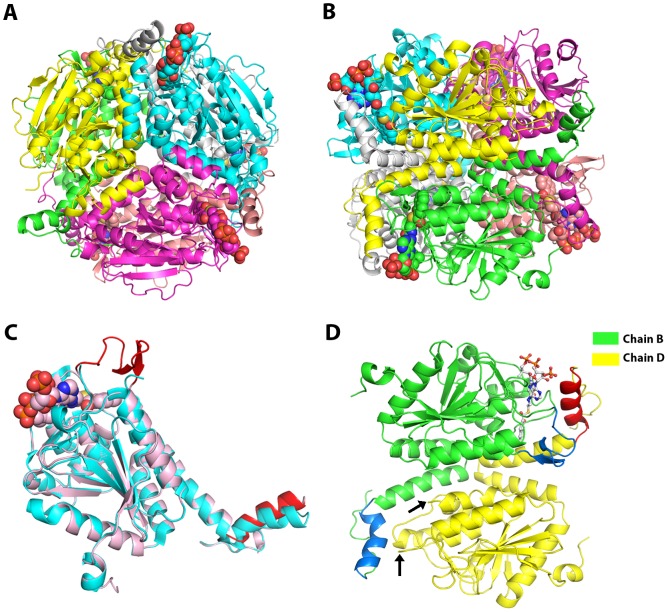
Overall structure of the ecMenB: HNA-CoA complex.(A) The hexameric assembly of ecMenB:HNA-COA complex viewed along the 3-fold axis of the trimers. The protein is colored by chain and HNA-CoA is shown in sphere. (B) Side view of the hexamer in (A) along the trimer-trimer interface. (C) Superposition of a typical subunit of ecMenB: HNA-CoA (in salmon and red with the ligand in spheres) and a subunit of apo-ecMenB (PDB code: 4ELX, in cyan). The ordered A-loop (residues 88–105) and the re-oriented C-helix (residues 260–272) are highlighted in red. (D) Partial conformational changes in a ligand-binding subunit (chain B in green and marine) and its opposing unliganded subunit (chain D in yellow and red) across the trimer-trimer interface. Chain B exhibits an ordered A-loop (in marine) and an unchanged C-helix (in marine), whereas chain D contains a disordered A-loop (the two ends are indicated by arrows) and a reoriented C-helix (in red). The HNA-CoA ligand in chain B is shown in sticks.